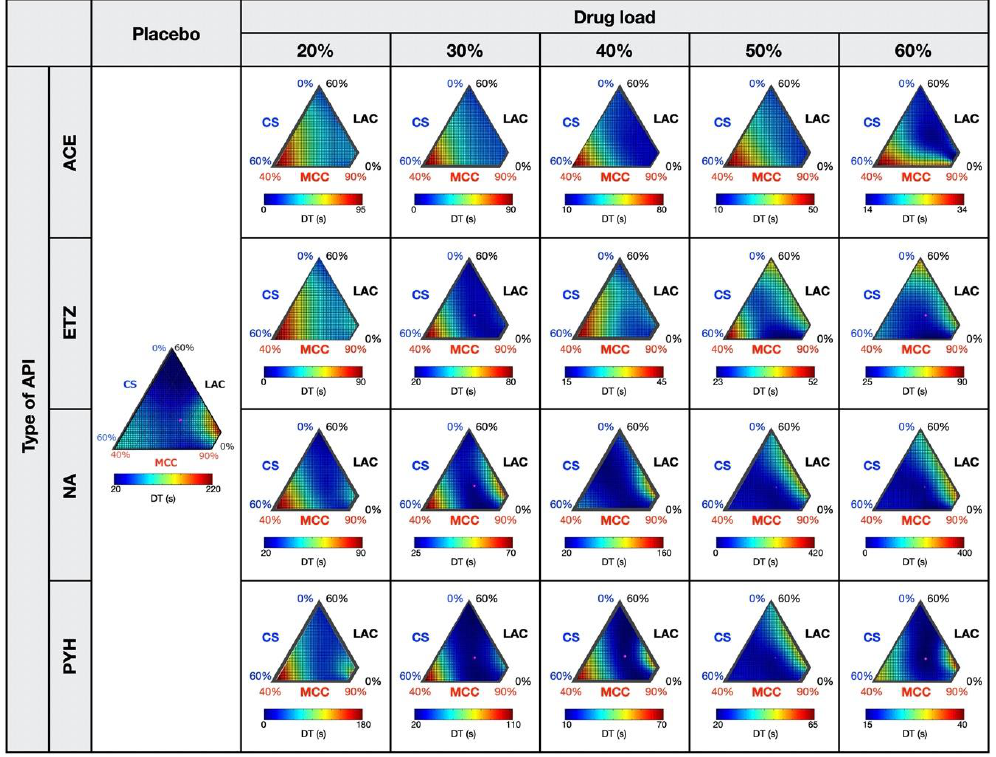
Figure 3. The response surface generated by RSM-S for the disintegration time (DT) of each tablet. The response surface of the placebo tablet is taken from our previous study [22].